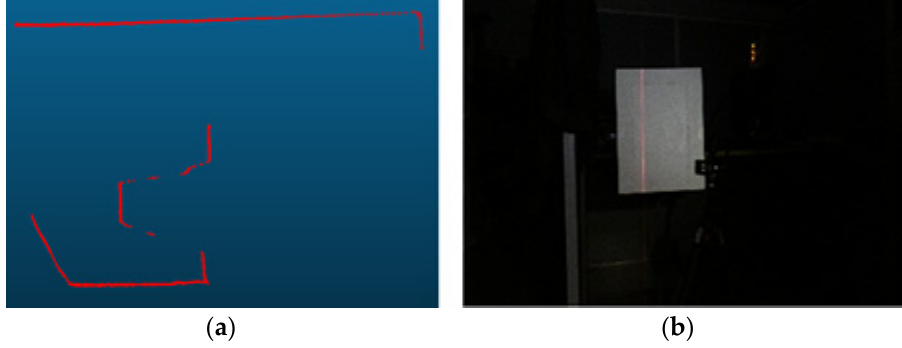
Figure 3. Example of data acquisition process using a calibration plate. ( a ) Depth information obtained from LiDAR; ( b ) Image information obtained from stereo camera.